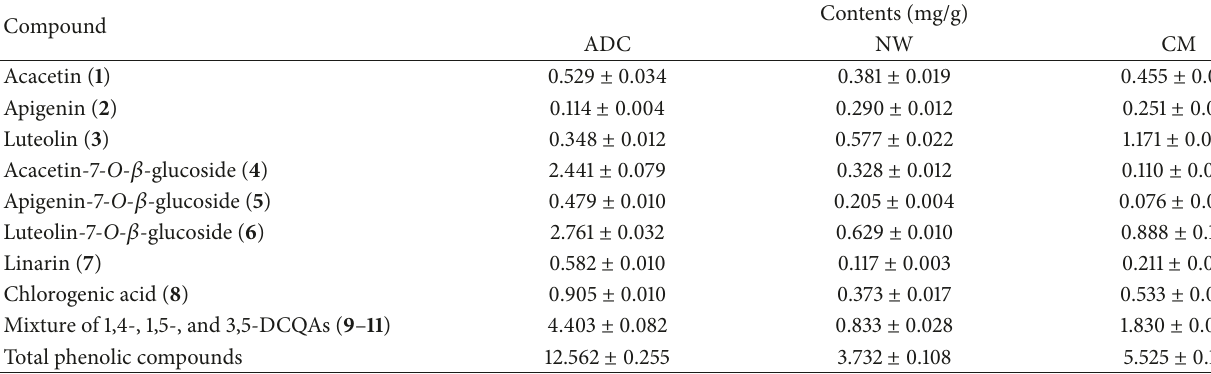
Table 4: Contents of compounds 1 – 8 and a mixture of 9 – 11 in the three flowers (Mean ± SD, n = 3).